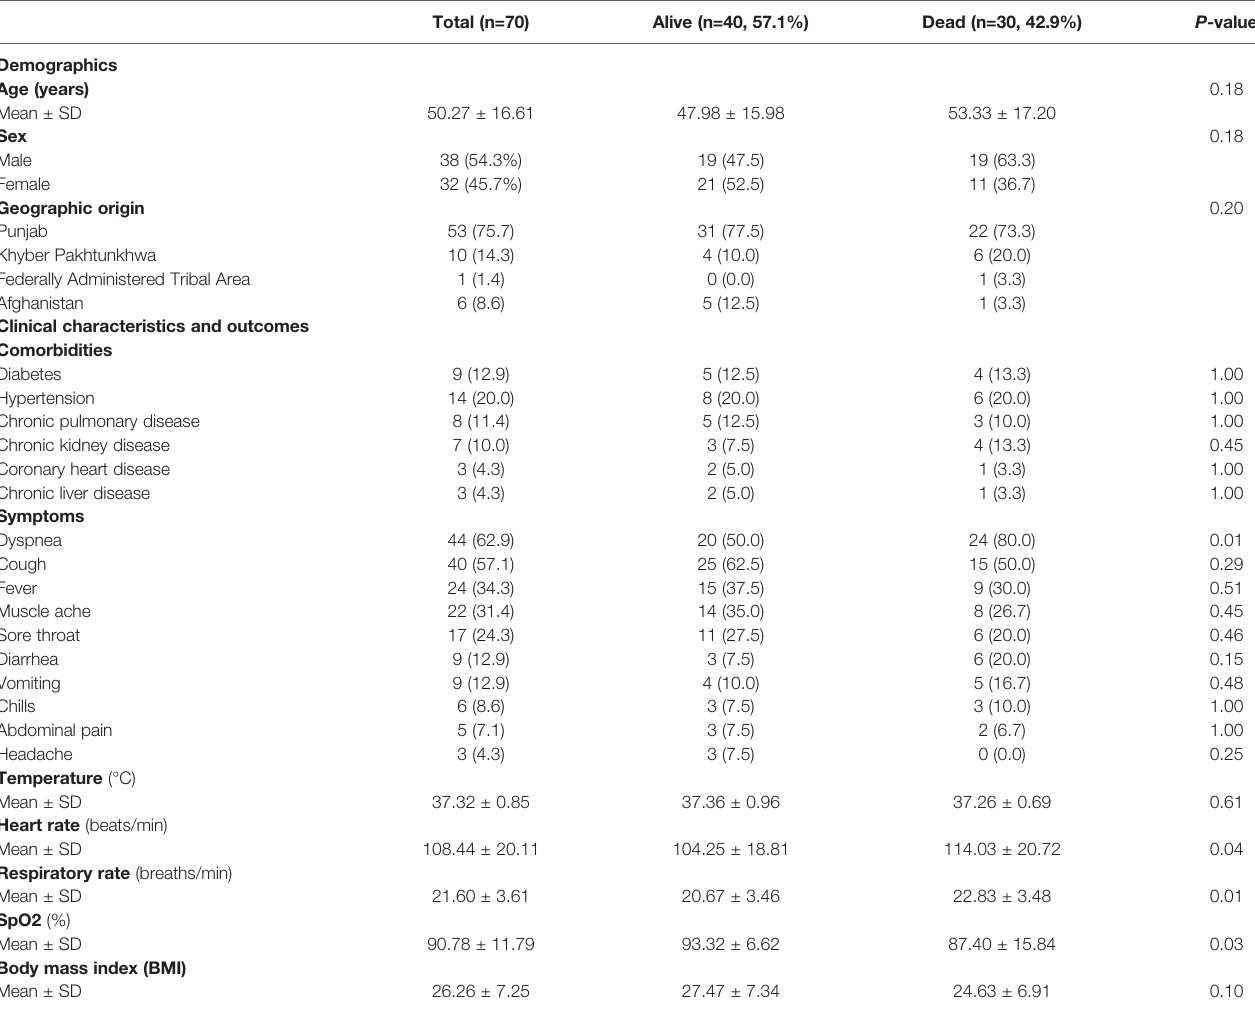
TABLE 1 | Demographics and baseline characteristics of patients with cancer and